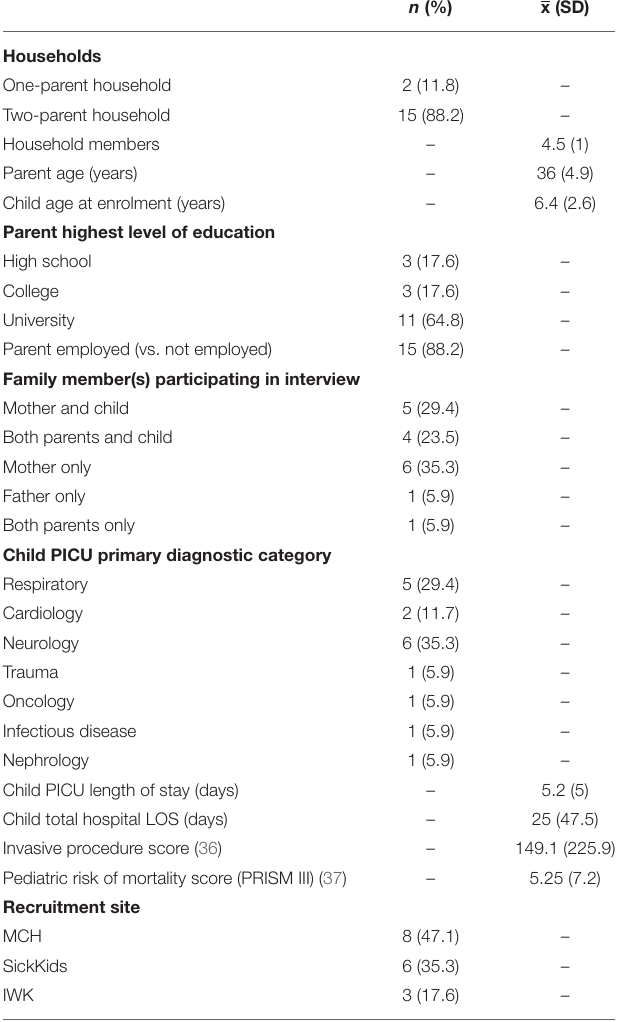
TABLE 2 | Family demographics and hospital baseline characteristics ( n = 17) *